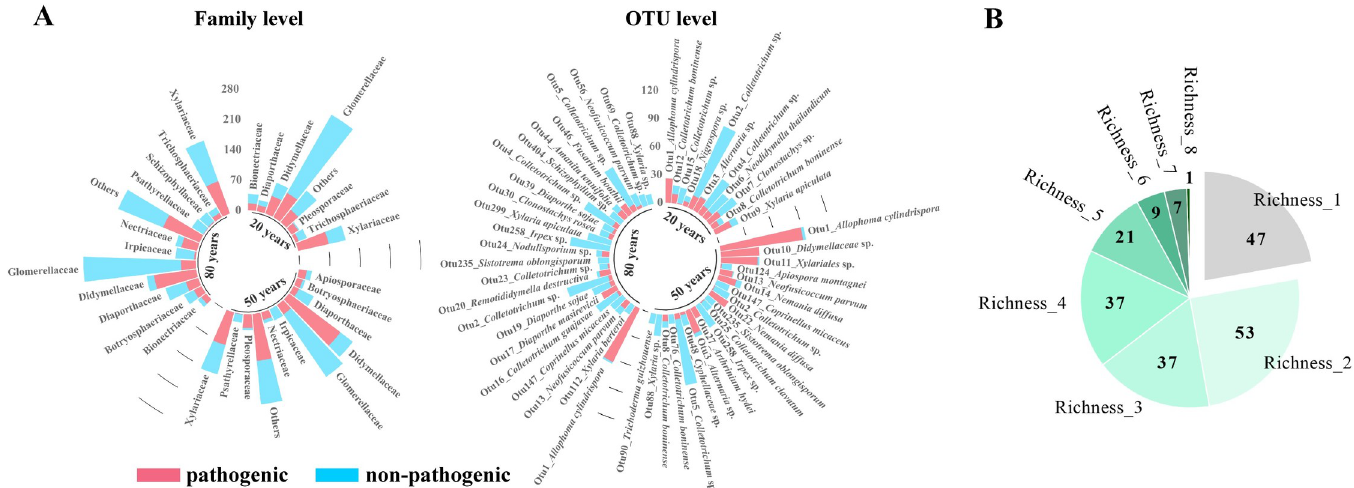
Fig 1. Isolation and virulence verification of leaf spot fungi. (A) The distribution of A . adenophora pathogens at the family (left) and OTU levels (right). Only families with relative abundance > 2% are shown, and the rest are merged into "Others"; only OTUs with relative abundance > 1% are shown. Each bar represents the abundance of one family (left) or one OTU (right) isolated from A . adenophora at the ~20 y, ~50 y and ~80 y sites, respectively; the part in the red represents those fungi virulent to A . adenophora verified by a disease experiment. (B) The categories of leaf spots with varying pathogenic fungal species. The number in each section represents the number of leaf spots with the corresponding pathogen richness. The green sections contain leaf spots with multiple infections, and the gray section contains those leaf spots with a single